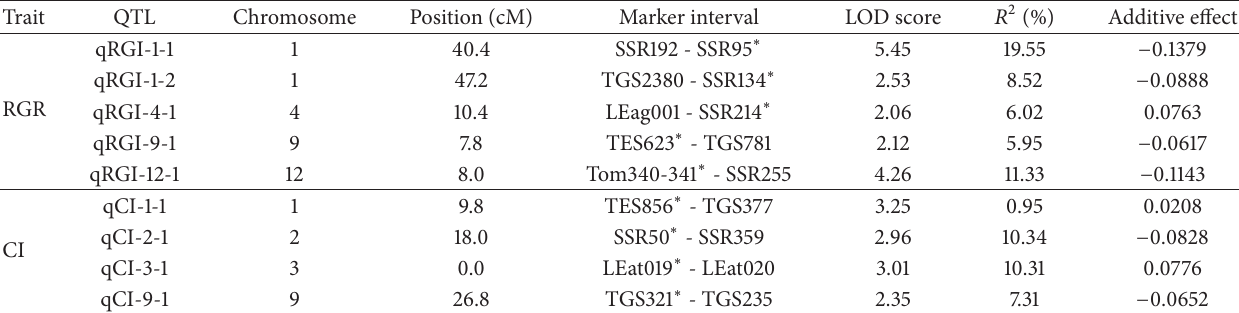
Table 2: QTLs analysis for cold tolerance in RIL population using CIM